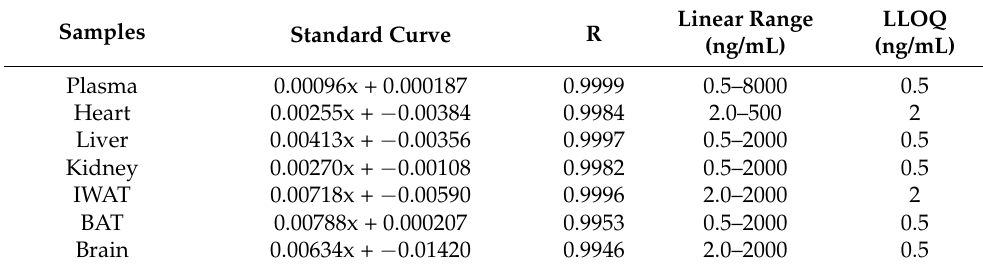
Table 2. Equations of 13 C 4 SA for quantification in plasma and different tissues in mice.